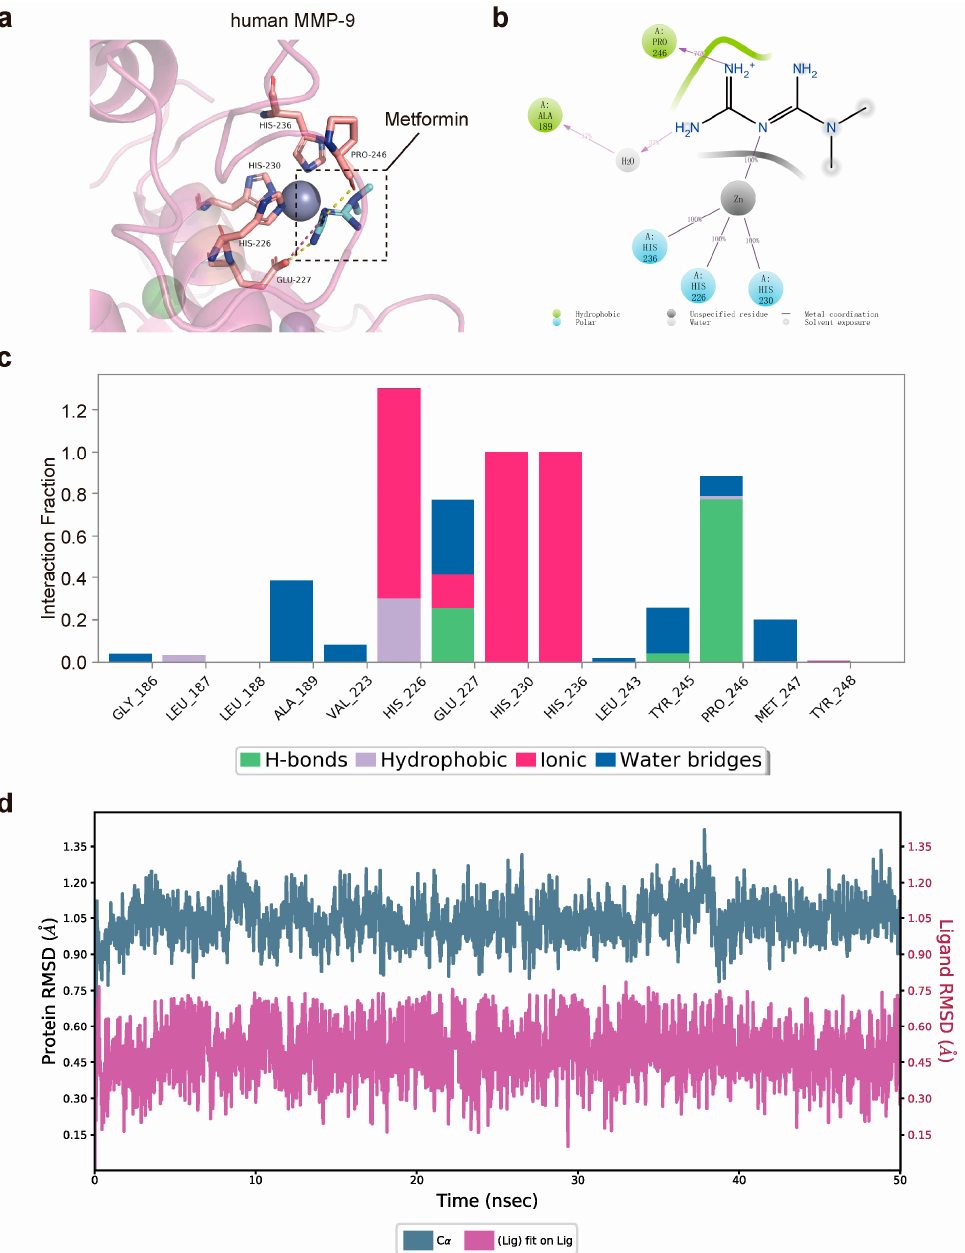
Figure 1. Matrix metalloproteinase-9 (MMP-9) is predicted to bind directly to metformin. ( a ) Predicted binding mode of metformin with MMP-9 (PDB id: 4wzv). ( b , c ) Protein–ligand contact histogram of metformin and the corresponding two-dimensional diagram predicted through MD simulations. A percentage value suggests that for X% of the simulation time, the specific interaction is maintained. ( d ) RMSD of the interaction between MMP-9 and the ligand metformin in MD simulations. MD, molecular dynamics; RMSD, root mean square deviation; MMP-9, matrix metalloproteinase-9.